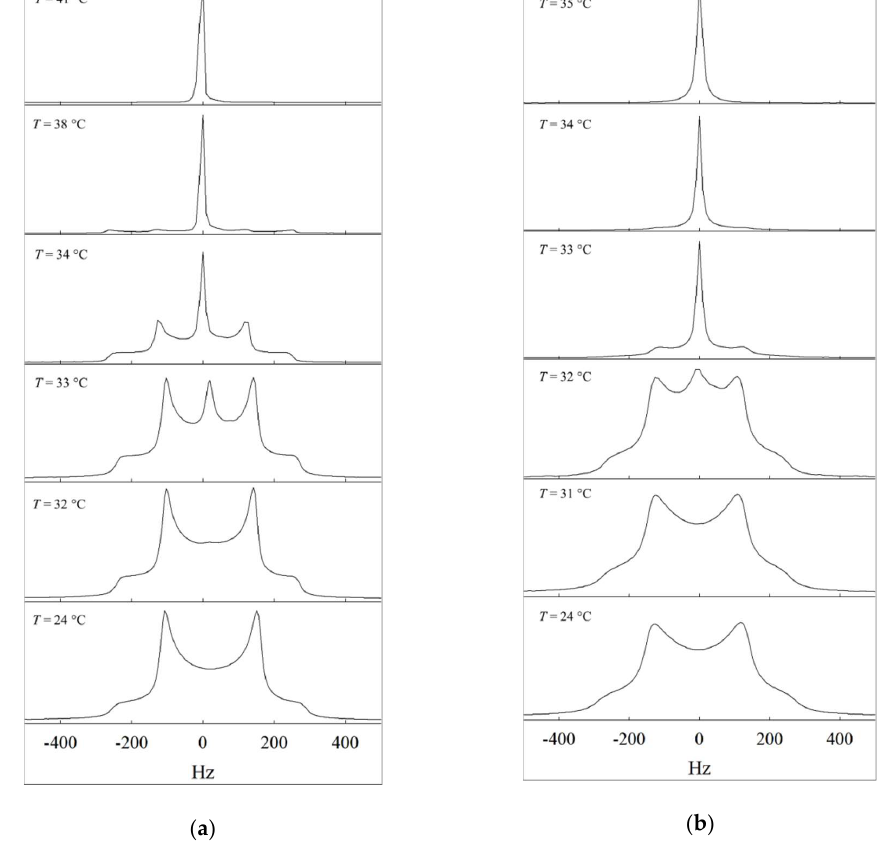
Figure 2. ( a ) Temperature dependent 2 H NMR spectra of the system D 2 O–C 12 E 7 , recorded at γ a = 0.38. ( b ) Temperature dependent 2 H NMR spectra of the system D 2 O–C 12 E 7 –12-HOA, recorded at γ a = 0.38 and η = 0.015.